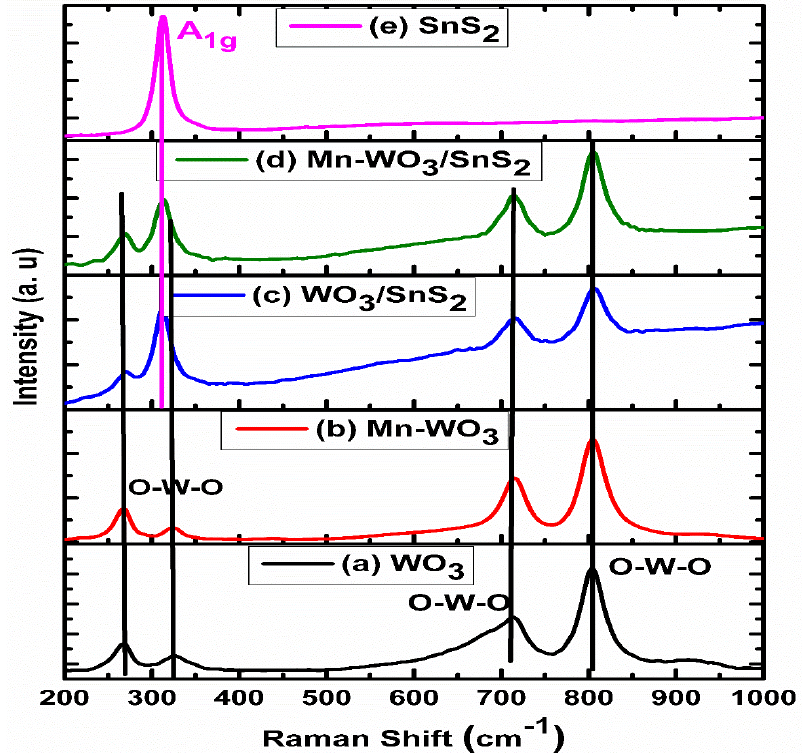
Figure 2. Raman spectra of ( a ) WO 3 , ( b ) Mn-WO 3 , ( c ) WO 3 /SnS 2 , ( d ) Mn-WO 3 /SnS 2 and ( e ) SnS 2.